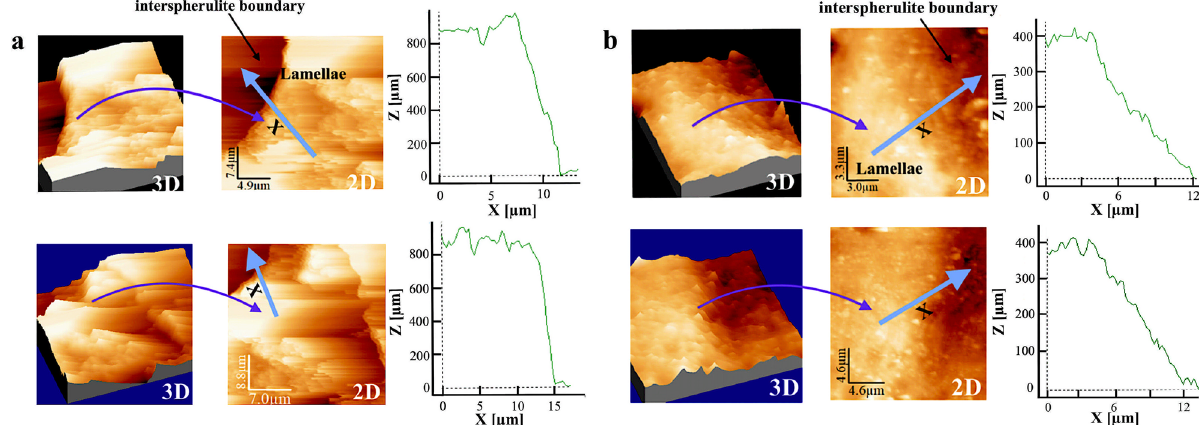
Figure 6. AFM height images and height profiles starting from the spherulite and ending at the interspherulitic regions (as presented in the 2D view) of (a) neat PU, and (b) adhesion interference on the spall strength of polydimethylsiloxane and polyurethane reinforced with alumina particles. Their spall testing results were obtained for composites reinforced with pristine alumina (untreated), and for composites based on silane treated alumina with reduced interfacial chemical adhesion to the polymeric matrix. Their results point out that the reduction in the filler/polymer adhesion generates a significant decrease on the composite spall strength. However, our results do not only show evidence of a good filler/polymer adhesion, they also indicate the ability of the HNT to be integrated into the final polymer microstructure. As shown in the FESEM images (Figs. 4b and 5a) we did not observe evidence of nanotube pullout, and the occurrence of different spherulitic morphologies suggests that the role of the HNT is to alter the final macromolecular organization of PU. This implies that HNTs in this system play a different role than a conventional reinforcement filler. Conventionally, the positive effects attributed to filler particles in a polymer are the action of the filler as a barrier to fracture growth via crack-front pinning and bowing, and fiber pull-out 44,45 . Here, we see that the HNTs affected the spherulitic structure development and therefore the final morphology of the polymer. The failure mechanism of the spherulitic structure observed under high strain conditions differs from what is expected under quasi-static conditions for PU. In a quasi-static tensile testing configuration, one would expect the elongation of the soft domain matrix combined with the tilt of the hard segment lamellar domains. The spherulite structure would be deformed to an ellipsoidal shape, and upon stress release the spherical shape would be restored by retraction. Thus, the soft matrix presents an elastomeric behaviour with the hard domains acting as physical cross-link sites 7 . Under dynamic tensile loading, we have observed the brittle failure of the spherulites combined with the stretching of the interspherulitic regions. Similar to the response under quasi-static conditions, the ductility of the PU under dynamic conditions can be attributed to the soft domain stretching. However, the brittle fracture surface of the spherulites suggests that the dynamic failure of the hard segment lamellar domains is not accompanied by significant conformational motion. The AFM topology images of the spherulite/interspherulitic interface of the unfractured samples is presented in Fig. 6. Comparing the height profiles starting from the lamellar crystal bundle and finishing in the amorphous interspherulitic matrix for both materials, the height profile for the neat PU displays a more abrupt transition between the spherulitic and amorphous regions. The vertical height difference (∆z) between hill and valley is around 900 nm for the neat PU, and 400 nm for the nanocomposite. This difference in the height profile may be related to a higher volumetric contraction of the coarse spherulitic structure in the neat PU during crystalliza- tion. This would consequently increase the void formation tendency along the boundaries and result in weaker and more brittle boundaries in the final microstructure 46 . Furthermore, the bonding of the HNTs to the hard segments promotes the micro-phase separation of the nanocomposite, which results in a higher chain mobility of the soft segments 37 . As the interspherulitic regions of the PU are mainly formed by soft segments, the presence of a less restricted molecular motion can lead to a more ductile behaviour of these regions. Thus, the higher volume contraction, combined with a higher hard segment concentration in the interspherulitic regions, are factors that contribute to the more brittle behaviour experienced by the neat PU. In the fractography images (Fig. 7a,b) it is possible to observe a more brittle behaviour in the interspherulitic regions of the neat PU, and for the nanocomposite a more ductile behaviour with extensively deformed regions around the spherulite.